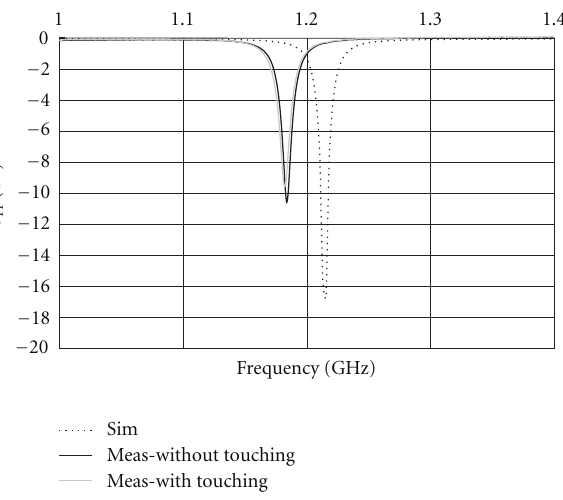
Figure 3: S 11 characteristics with and without touching the SMA connector connected to the